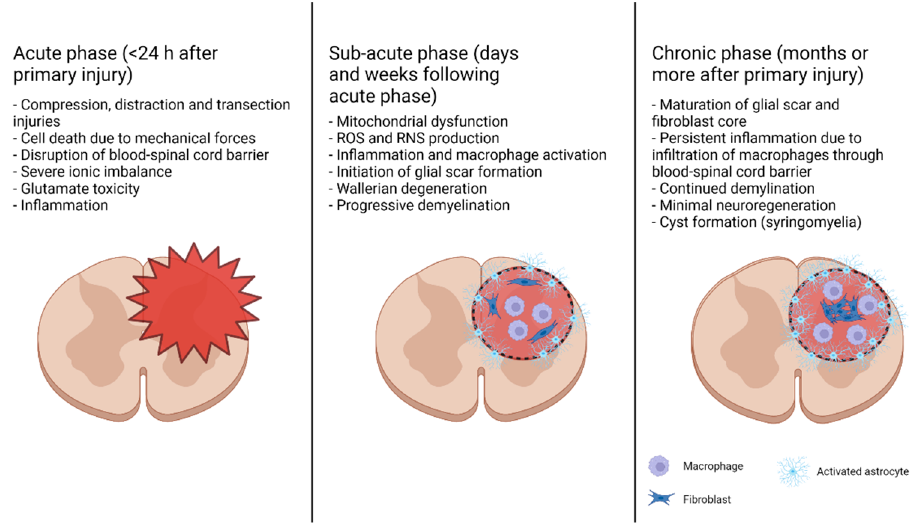
Figure 2. Secondary phases of SCI. After the primary traumatic injury (compression, distraction, transection, etc. of the spinal cord), the acute secondary phase immediately follows. Mechanical force ruptures cells and disturbs the blood–spinal cord barrier, allowing entrance of the blood-born immune cells into the lesion site. Glutamate excitotoxicity and disruption of the ionic balance led to mass necrosis. After about 24 h, the subacute phase begins, marked by the initiation of an astrocyte-based glial scar around the lesion. The damaged mitochondria release damaging ROS, causing the axons near the lesion site to begin to demyelinate and die back. In the chronic stage, the glial scar matures, and a fibroblastic core is formed. The blood–spinal cord barrier remains disrupted, leading to chronic inflammation. Axon demyelination and degeneration continues. The presence of the scar chemically and physically hinders neuroregeneration.